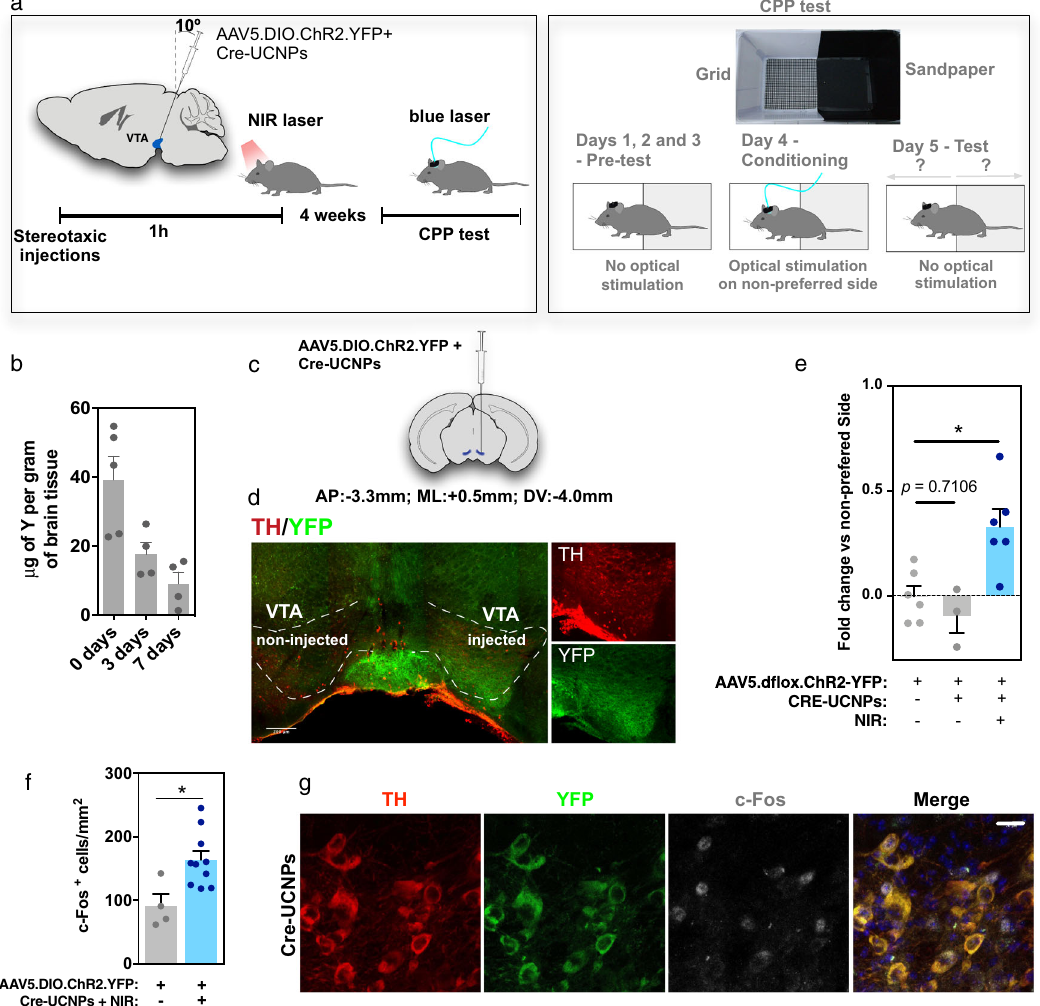
Fig. 6 In vivo gene editing with Cre-UCNPs followed by functional analyses of the edited cells by optogenetics. a Schematic representation of the in vivo setup. AAV5.d fl ox.ChR2-YFP was injected into the VTA together with Cre-UCNPs (30 µ g). Following stereotaxic injection, the target site was irradiated by a NIR laser (980 nm, 425 mW/cm 2 for 3 cycles of 5 min) to induce the release of Cre from the NPs. After 4 weeks, animals were subjected to a CPP test, where the animal ’ s preference for one of two regions with contrasting visual and tactile cues in a cage was monitored for 3 days using an automated mouse tracking system. On day 4, whenever the mouse crossed into the non-preferred region of the cage, the VTA was activated with blue light; on the fi nal test day, the animals were re-introduced into the cage to assess changes in preferences. b Quanti fi cation of Cre-UCNPs accumulated in the brain of mice was performed in dried tissue by ICP-MS at days 0, 3, and 7 post stereotaxic administration. Results are Mean ± SEM (n = 4 – 5 animals). c Local of injection of Cre-UCNPs. d Expression of ChR2-YFP (green) in the TH-positive region (red) of the VTA, as evaluated by immuno fl uorescence. Of note the differences in fl uorescence between left and right VTA ( n = 6 animals). e CPP test to evaluate behavioral changes in preference (fold change in the time spend on the non-preferred chamber before and after blue light stimulation). Results are Mean ± SEM, obtained from n = 3 (CRE-UCNPs), or 6 (Negative control and CRE-UCNP + NIR) animals. Statistical analysis was performed by one-way ANOVA followed by Tukey ’ s multiple comparisons test: (*), P = 0.0115. f Expression of c-Fos positive nuclei in the VTA, following stimulation with blue light. Results are expressed as Mean ± SEM (2 – 5 animals per condition; for each animal, c-Fos was quanti fi ed in 2 – 3 regions in VTA slices, 4-13 fl uorescence images per slice) and analyzed by unpaired two-tailed t test: (*), P = 0.024. g Representative confocal images of a mouse treated with Cre-UCNPs showing the expression of c-Fos (gray) and ChR2-YFP (green) in the TH positive region (red) of the VTA, from n = 5 animals. Scale bar = 20 μ